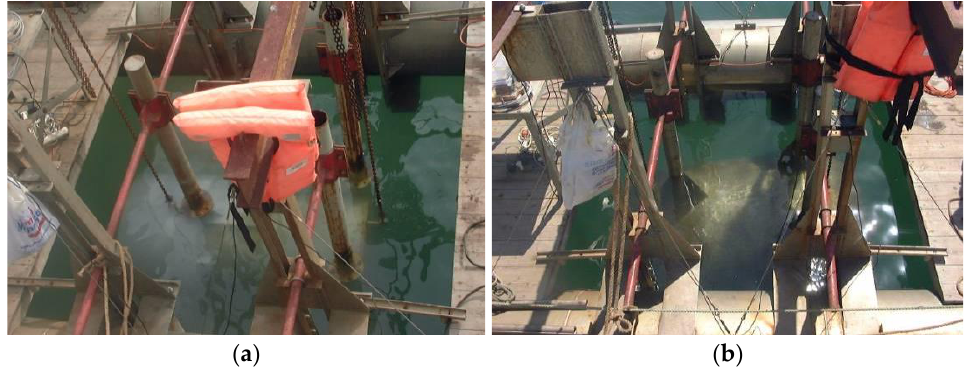
Figure 6. The duct scale models D2 ( a ) and D4 ( b ) at the lower level (totally immersed in the water) with the highest part about 0.5 m below the water surface, when the platform was tied to the quayside.